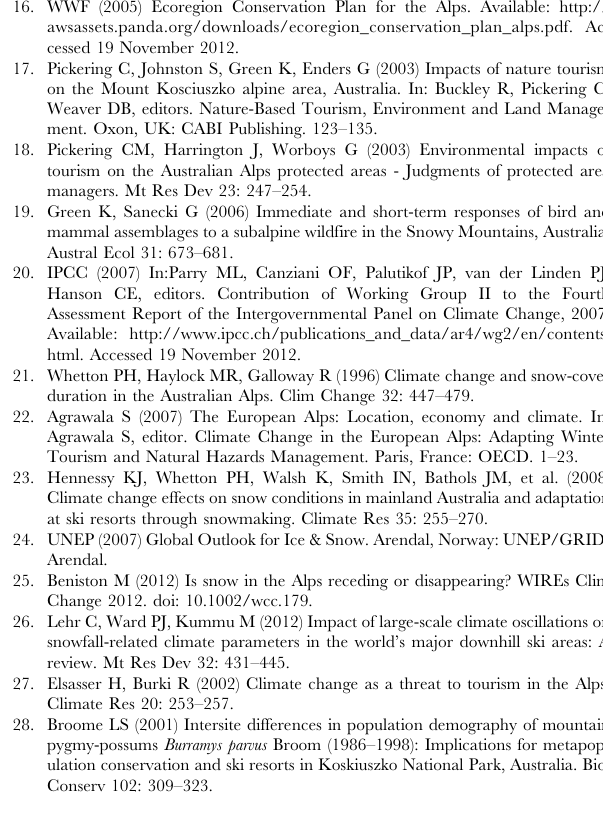
Table S2 Examples of positive, non-significant and negative effects for the four composite categories. Table S3 Comparison of the contribution of seven regions to the peer-reviewed literature investigating the impacts of ski-related disturbances on wildlife, compared with the proportion of all ski areas located in those seven regions (based on approximate numbers of ski areas provided by [38]). Table S4 Provision of management recommendations by region and time period. ‘‘Y’’ indicates that a recommendation was provided; ‘‘N’’ indicates that a recommendation was not